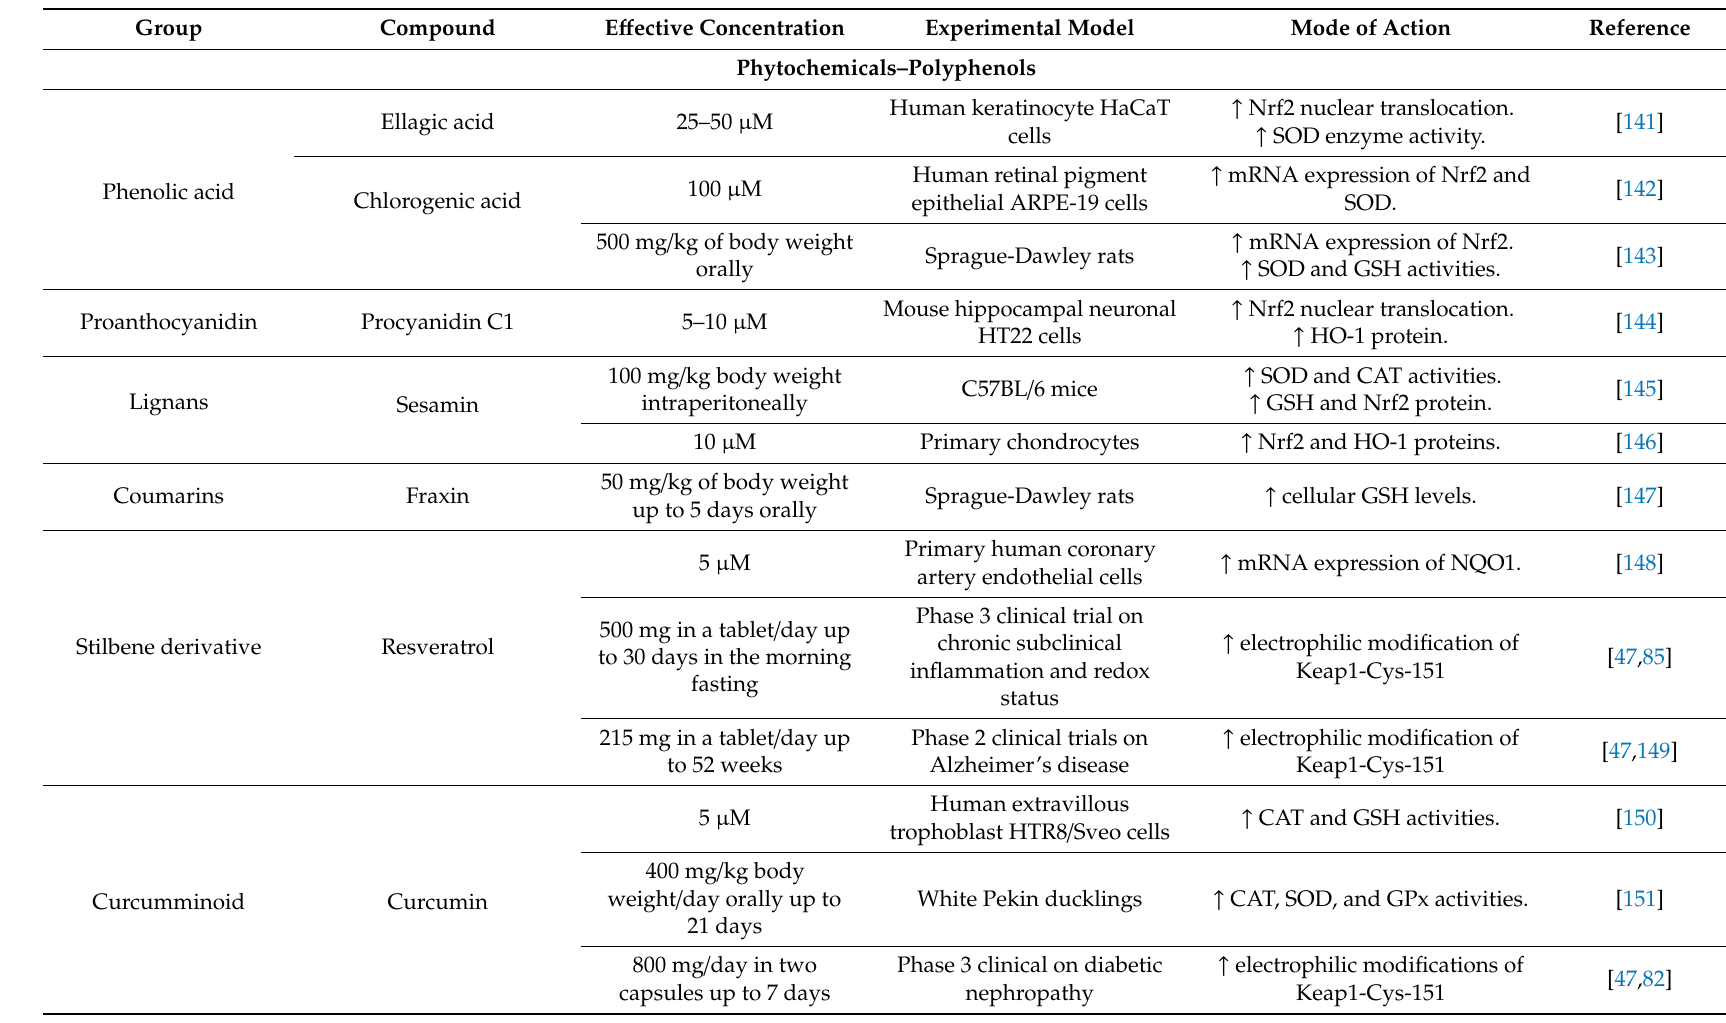
Table 1. Activators of the Nrf2 / ARE pathway in non-cancer experimental models: phytochemicals and other signal